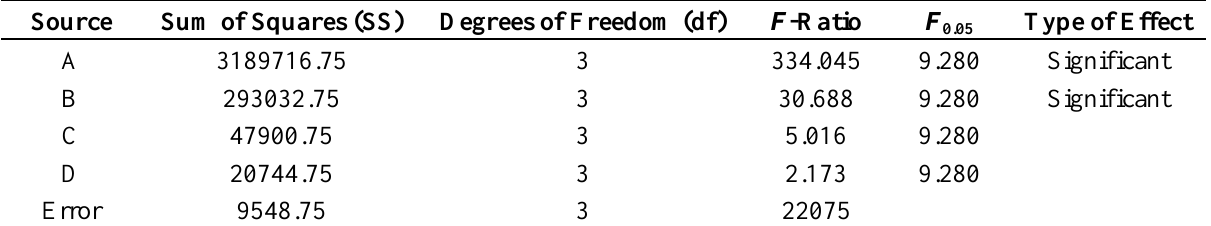
Table 2. ANONA analysis of four parameters for RESS micronization of